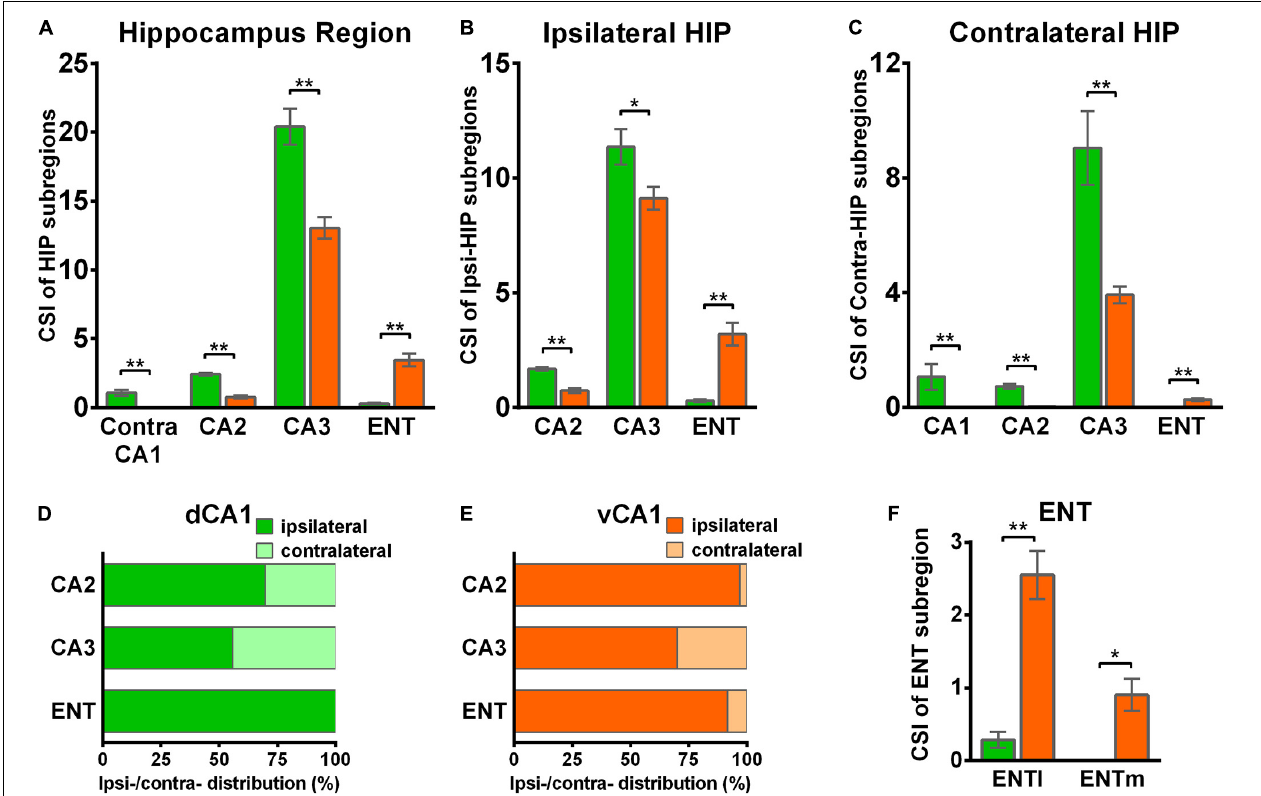
FIGURE 5 | Distribution patterns of HIP inputs between the two CA1 tracing groups. (A) CSI of the bilateral inputs in the different HIP subregions between two CA1 tracing groups. (B) CSI of the inputs in the ipsilateral HIP subregions between two CA1 tracing groups. (C) CSI of the inputs in the contralateral HIP subregions between two CA1 tracing groups. (D) Distributions of ipsilateral and contralateral input neurons within five subregions of HIP. (E) Distributions of ipsilateral and contralateral input neurons within five subregions of HIP. (F) CSI of the inputs in bilateral ENT subregions. n.s., no significant difference; * P < 0.05; ** P <